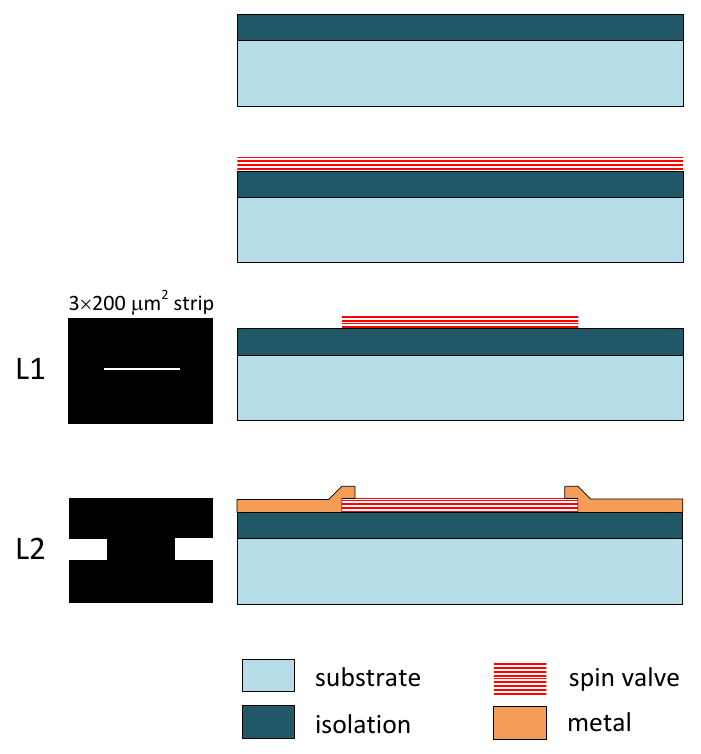
Figure 3. Basic fabrication process of a GMR elemental